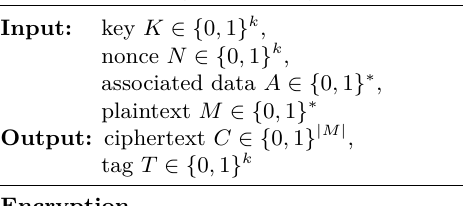
Algorithm 1 E ( K, N, A, M )